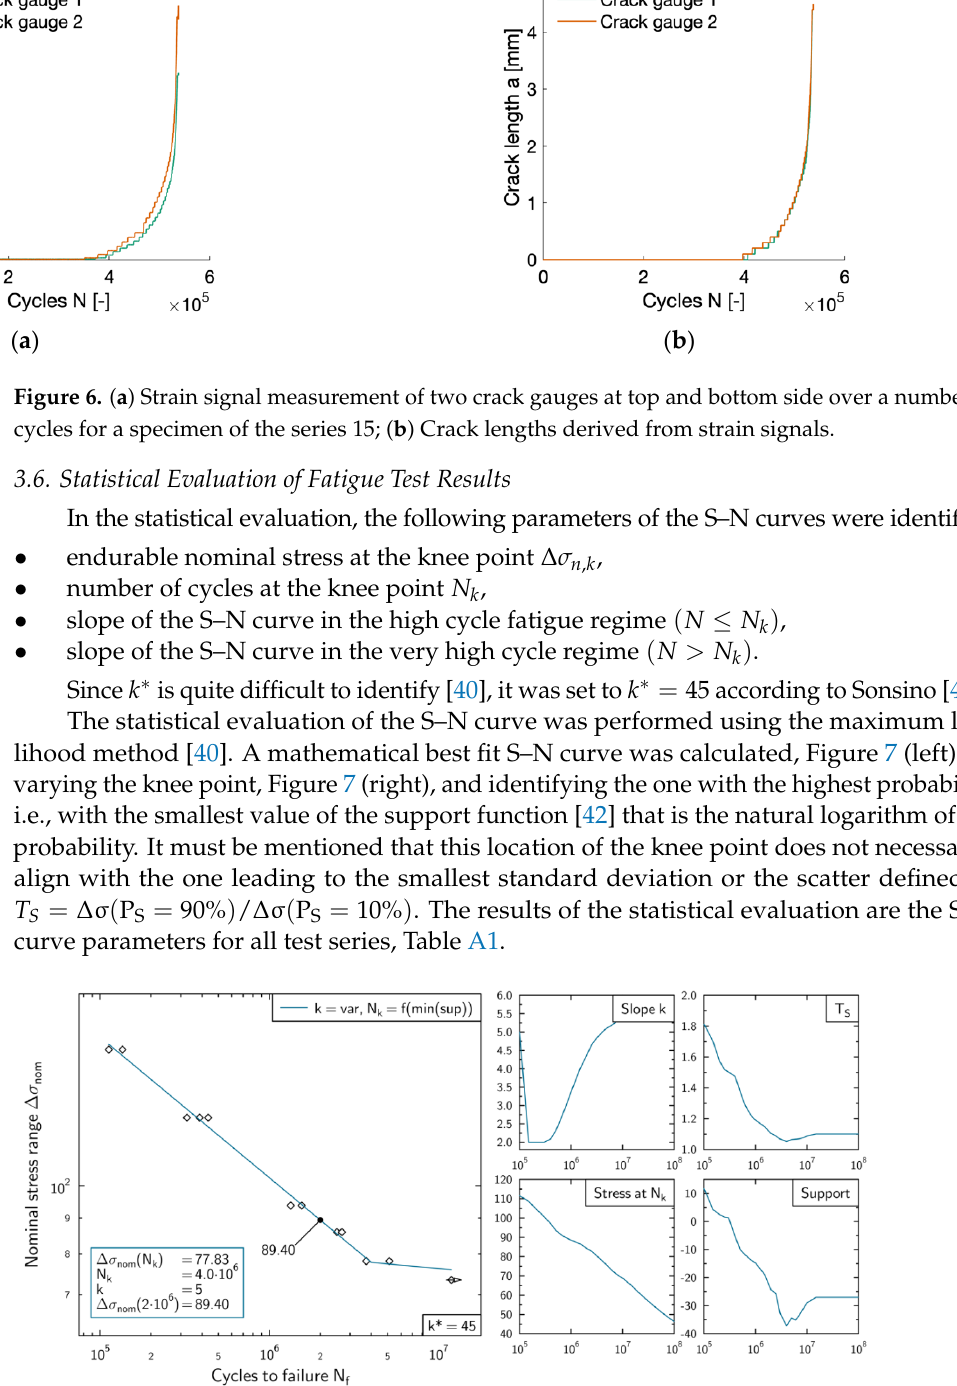
Figure 7. Example of a statistical evaluation of an S–N curve with maximum likelihood (test series 18). Left: Evaluated S-N curve, right: S-N curve parameters in relation to the position of the knee point 𝑁 𝑘